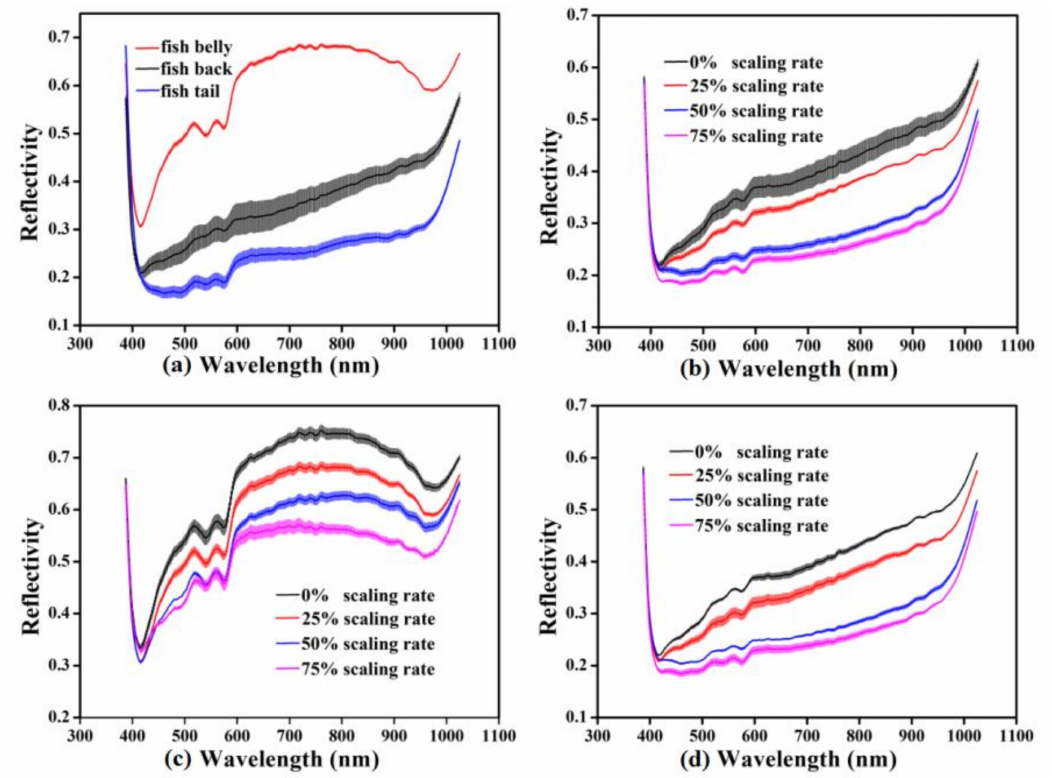
Figure 2. Original mean spectra with SD: ( a ) mean spectra of the back, belly, and tail regions without scaling; ( b ) mean spectra of the back region with di ff erent scaling rate; ( c ) mean spectra of the belly region with di ff erent scaling rate; ( d ) mean spectra of the tail region with di ff erent scaling rate.